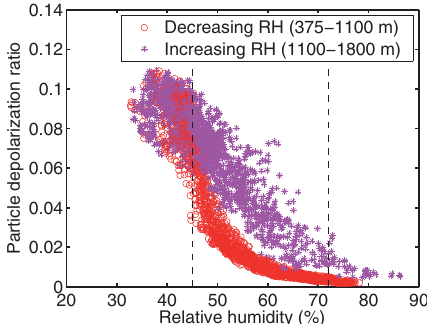
Figure 13. Correlation of the PLDR at 1064nm and RH for the same settings as in Fig. 12, but for a different height interval (375– 1800m). Above 1100m (purple stars) RH increases again, up to 80%, as can be seen in Fig. 9. The depolarization ratio decreases with increasing RH but keeps higher values. The hysteresis effect between crystallization (45–48% RH, dashed line) and deliques- cence (70–74% RH, dashed line) can be